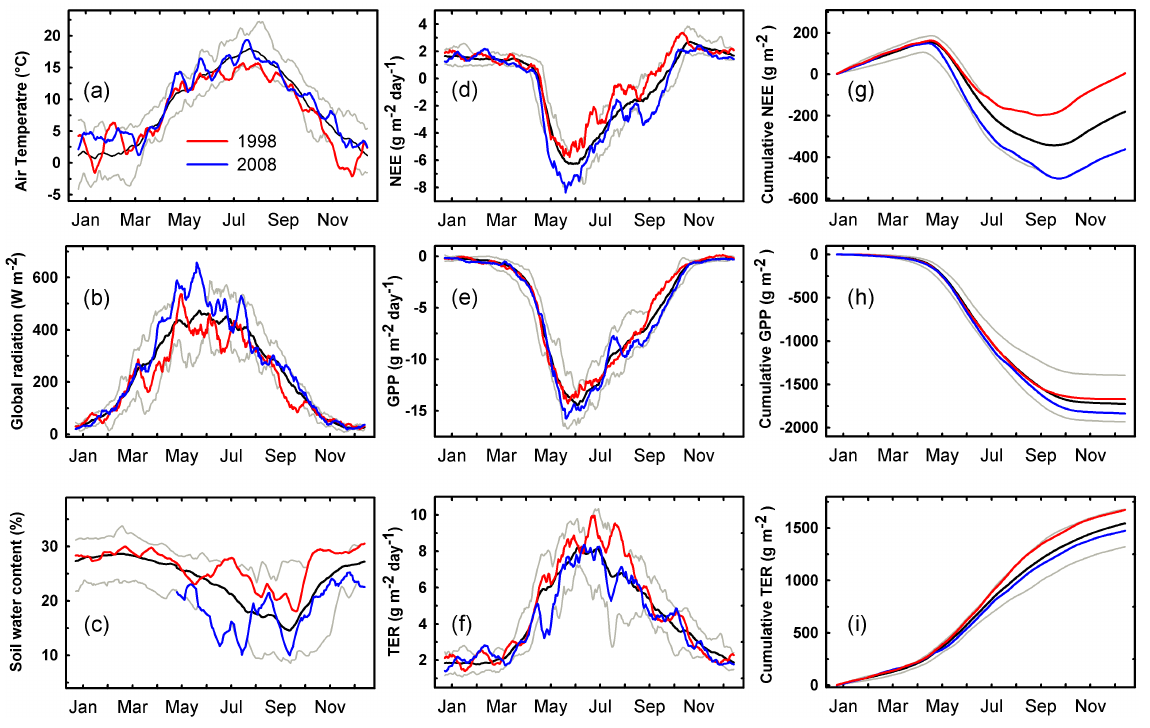
Fig. 3. The average (black line) and two example years (1998, 2008) in terms of climate (a, b, c) , carbon flux (d, e, f) and cumulative carbon flux (g, h, i) . All data were smoothed with a 14-day moving average. Grey lines indicate the maximum and minimum of the value on the same DOY across the 13yr.